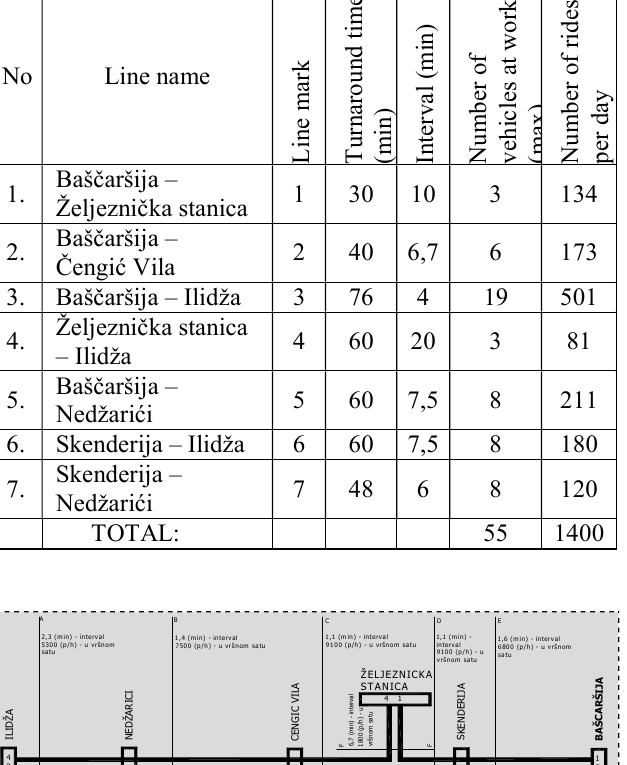
Table 1. Data on tram lines in Sarajevo (2010 with majority two-piece vehicles)